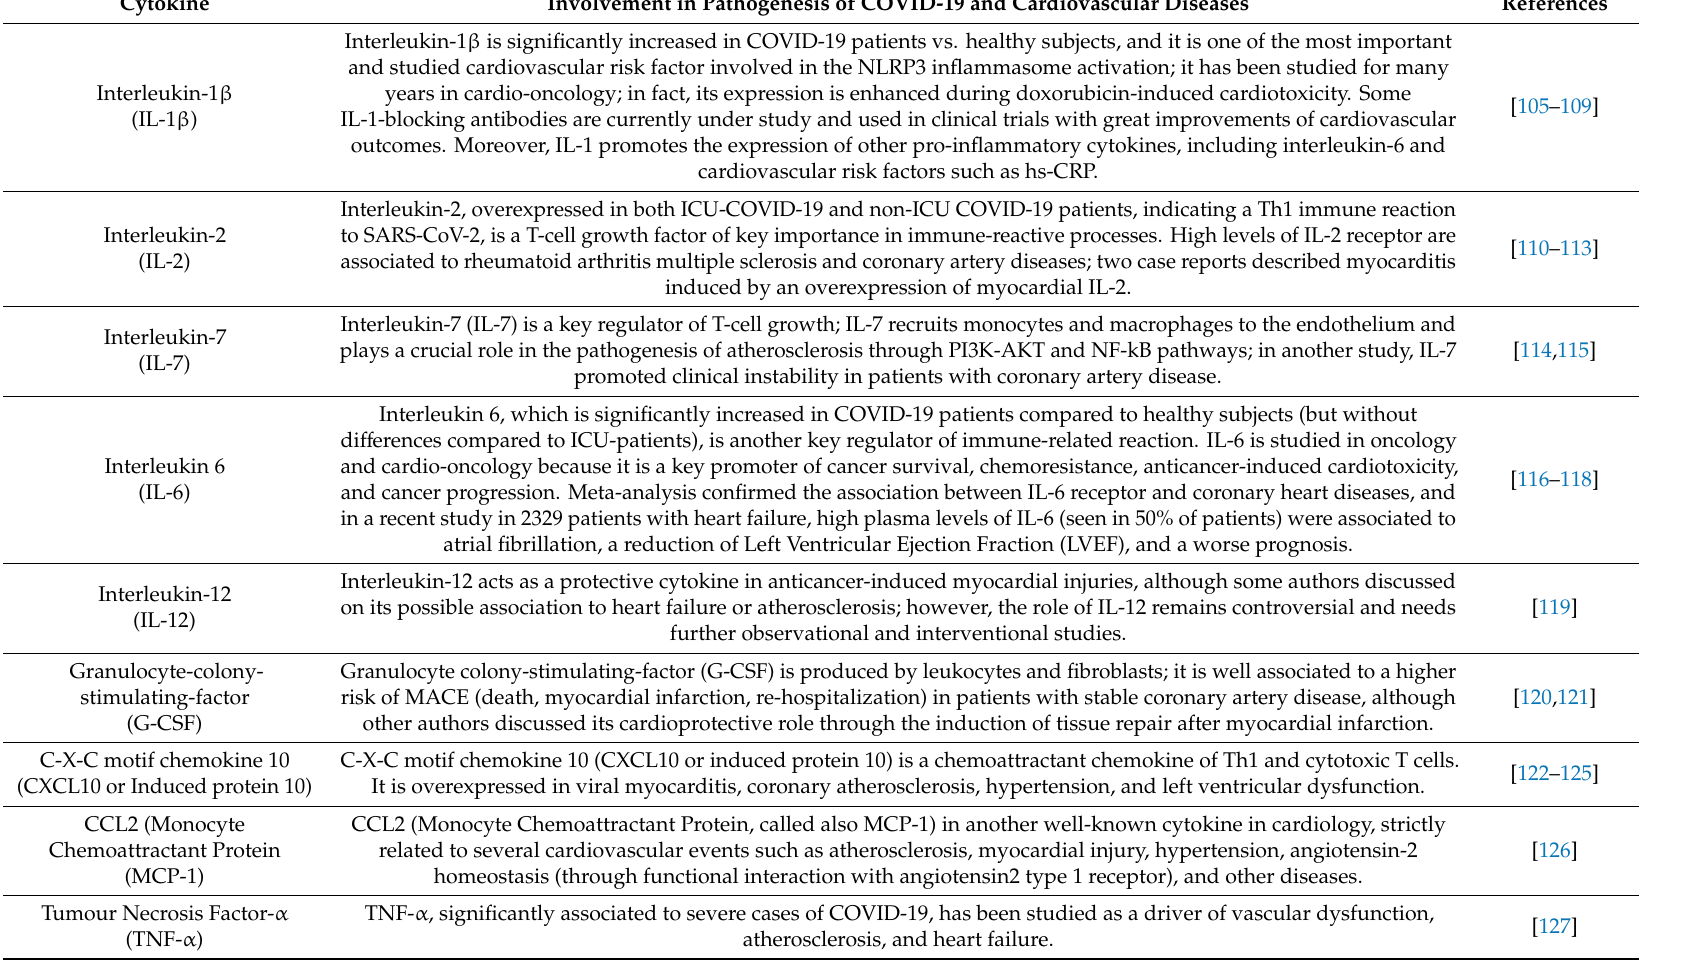
Table 2. Cytokines and chemokines storm induced by COVID-19 and di ff erences between healthy subjects, Intensive Care Unit (ICU), and non-ICU, COVID-19 patients. Data and p values from C. Huang et al., Lancet 2020